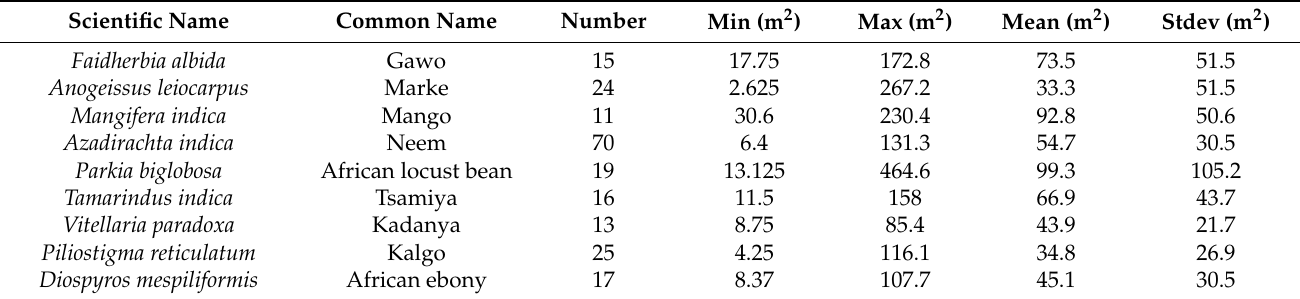
Table 2. Dominant agroforestry tree species, number of tree species in the sample, and their crown dimensions.